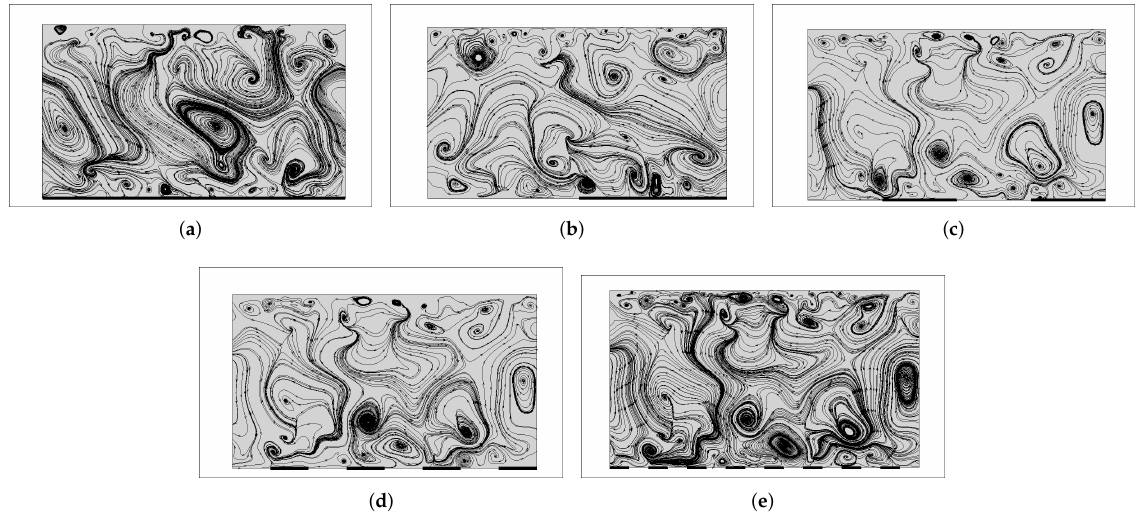
Figure 11. Streamlines at the YZ = 3.5 δ cutplane. ( a ) no-slip. ( b ) GF = 0.5, Strip number = 1. ( c ) GF = 0.5, Strip number = 2. ( d ) GF = 0.5, Strip number = 4. ( e ) GF = 0.5, Strip number =